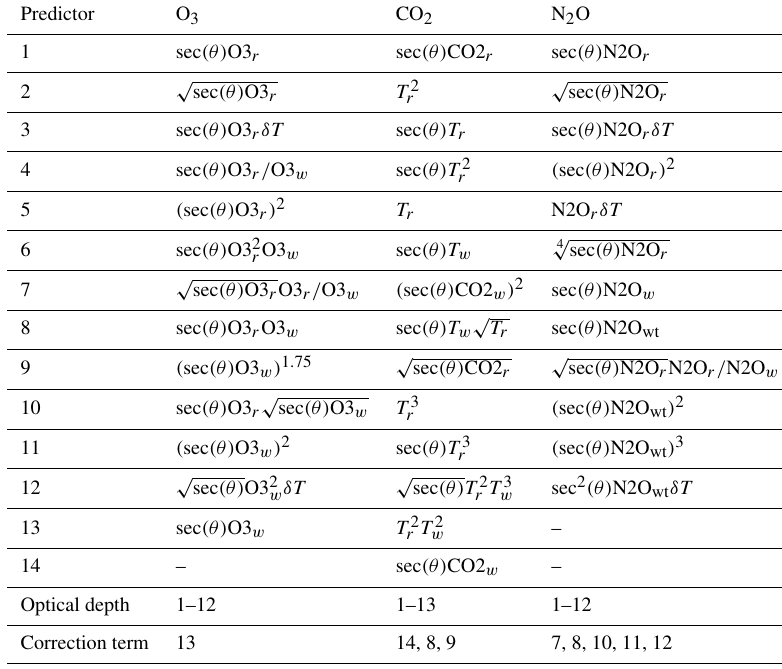
Table A3. O 3 , CO 2 , and N 2 O predictors and predictor lists for the optical depth and correction term.